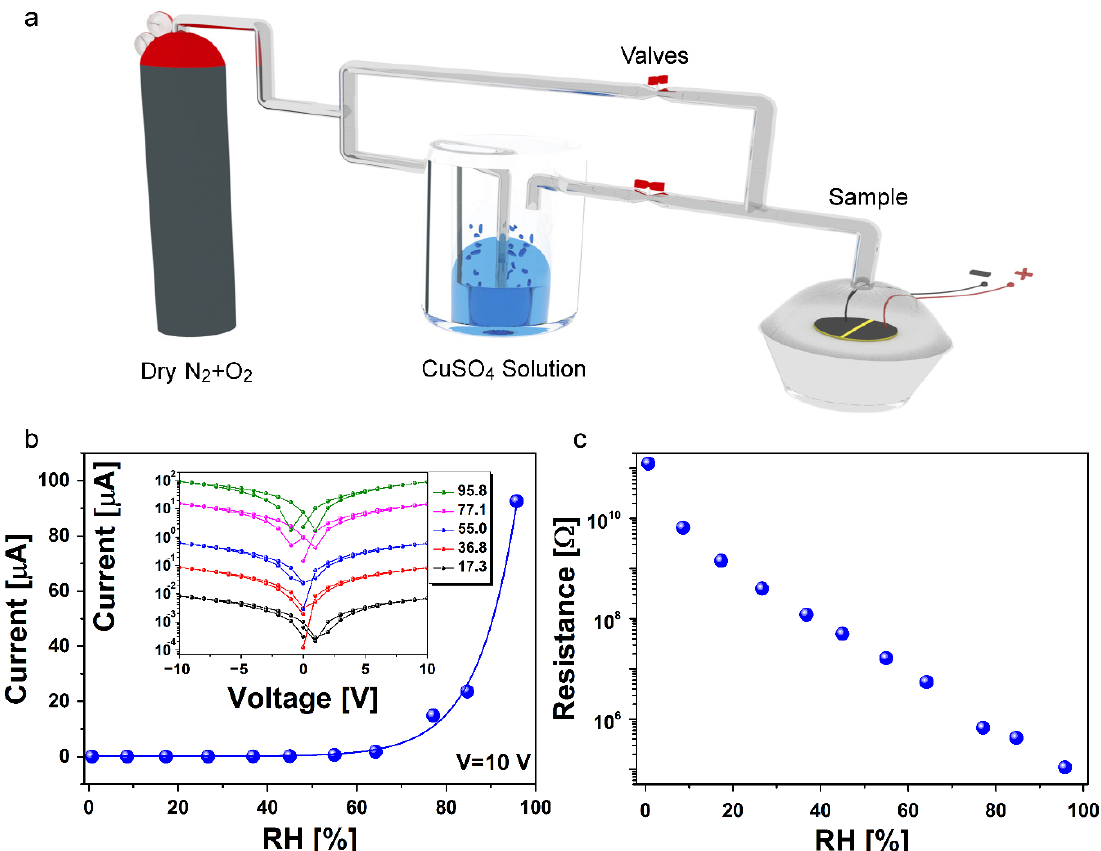
Figure 2. ( a ) Scheme of the experimental setup used for measurements. ( b ) Dependence of current at 10 V on RH at ambient temperature. The inset figure shows typical I–V curves from which the current at 10 V was extracted. ( c ) Linear dependence of the resistance of MA 3 Bi 2 Br 9 on